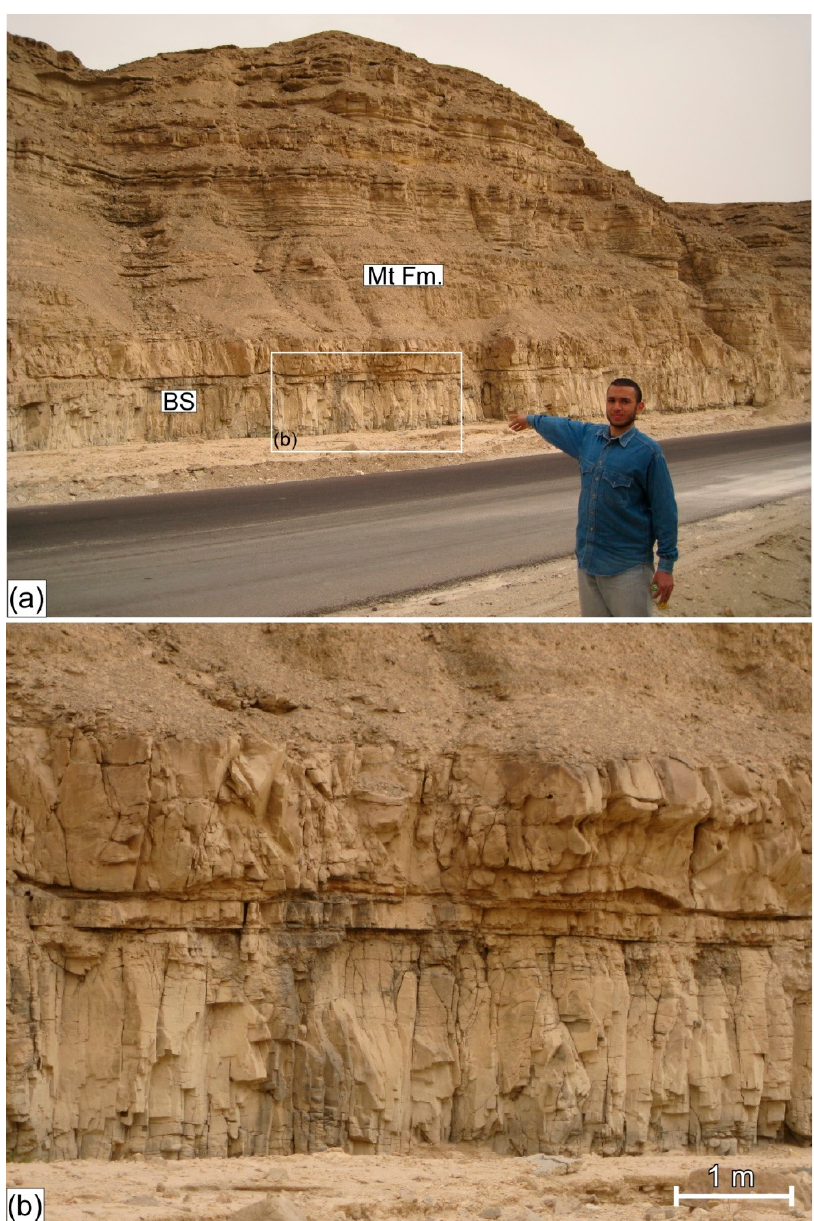
Figure 6. ( a ) General view of the horizontally bedded, clastic-dominated Matulla Formation (Mt Fm.) intruded by a 2 m thick basaltic sill (BS) at the entrance of Wadi Matulla. The man’s height is 175 cm. ( b ) A close-up view of inset (b) in (a) showing a well-developed columnar jointing in the basaltic sill.